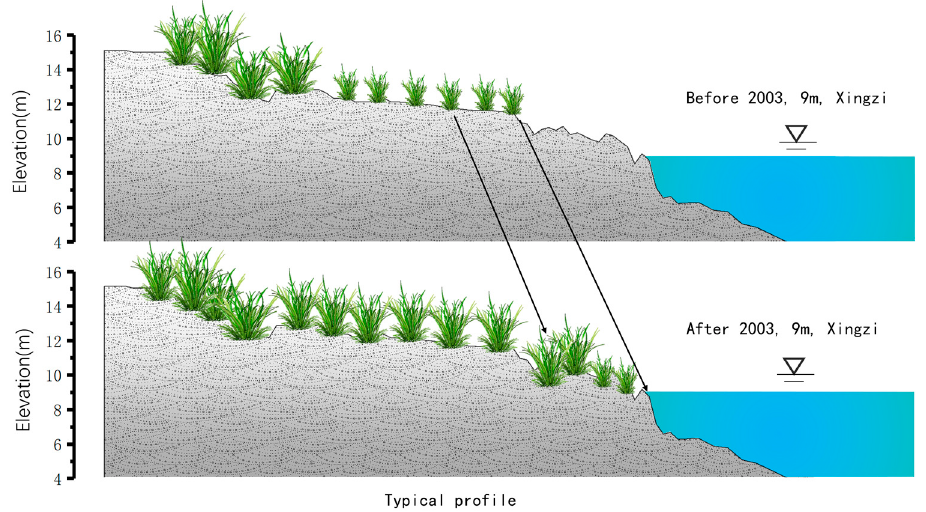
Figure 2. Characteristics of vegetation spread on Poyang Lake Wetland beach land before and after 2003.